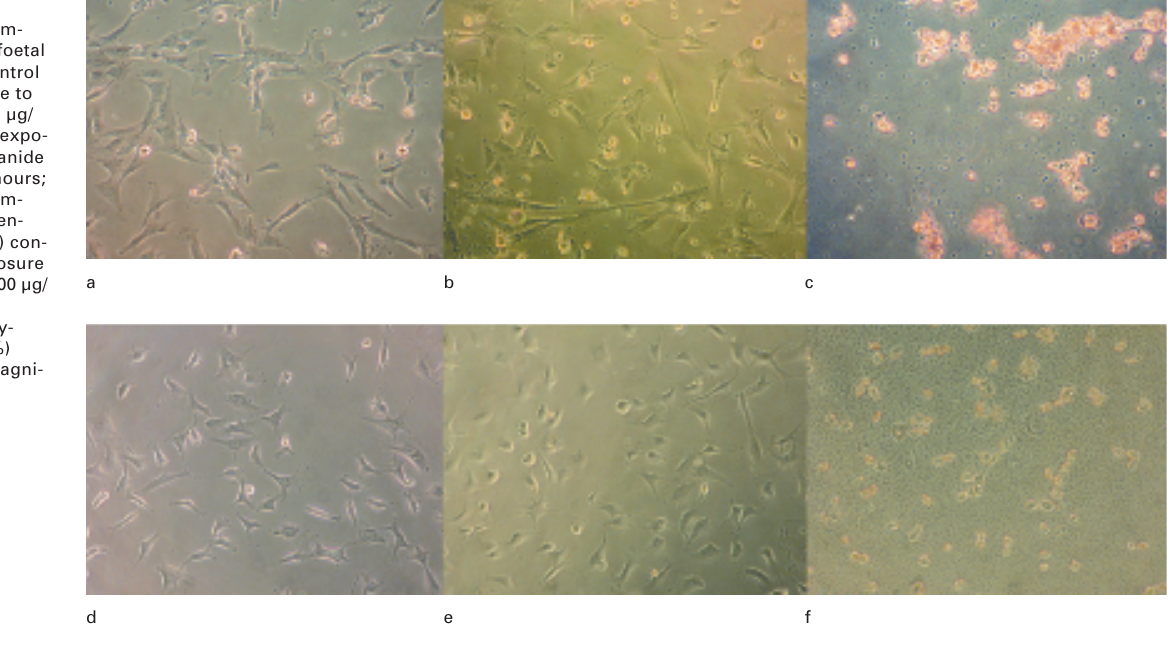
Phase contrast im- ages of human foetal osteoblast a) control b) after exposure to gentamicin (400 µg/ ml) and c) after expo- sure to polyhexanide (0.01%) for six hours; phase contrast im- ages of human en- dothelial cells d) con- trol e) after exposure to gentamicin (400 µg/ ml) and f) after exposure to poly- hexanide (0.01%) for six hours (magni- fication (cid:2)